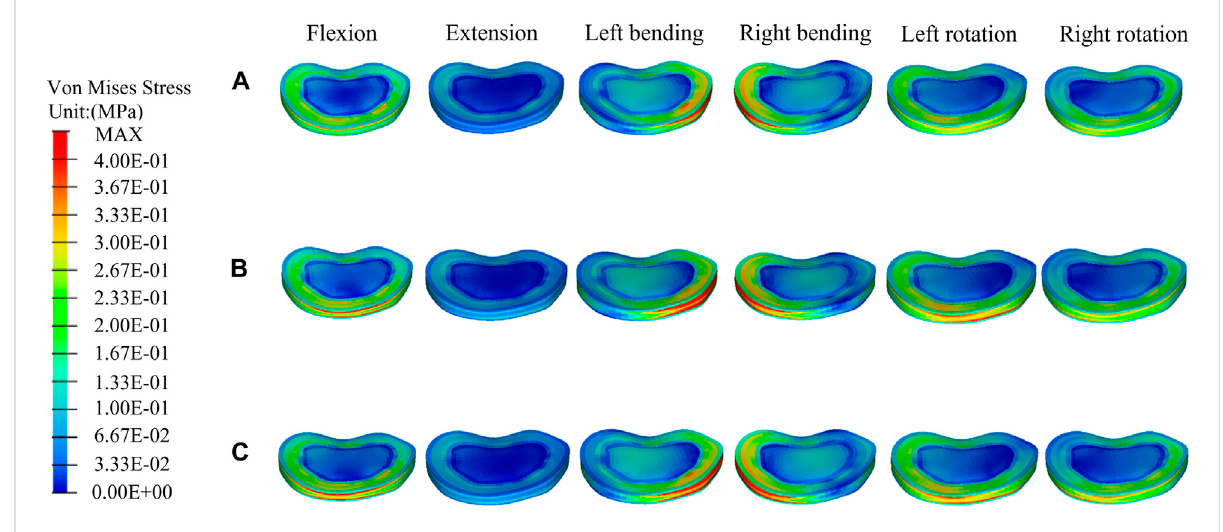
FIGURE 9 The distributions of the von Mises stress on the T11-T12 disc. The distributions of the von Mises stress on the T11-T12disc in a fractured model (A) , UPVP (B) , and BPVP (C) under fl exion, extension, left/right bending, and left/right torsion.